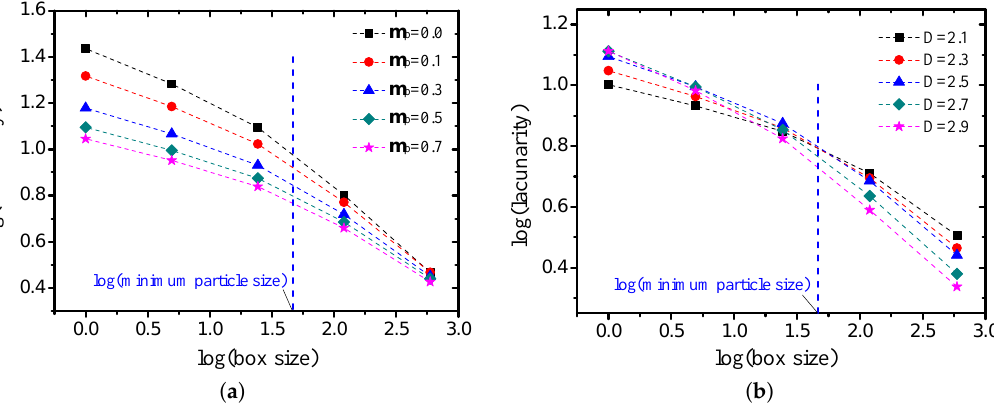
Figure 13. Variation in lacunarity with sliding box size (( a ) the fractal dimension D is 2.5, while the friction coefficient takes different values; ( b ) the friction coefficient µ p is 0.5, while the fractal dimension takes different